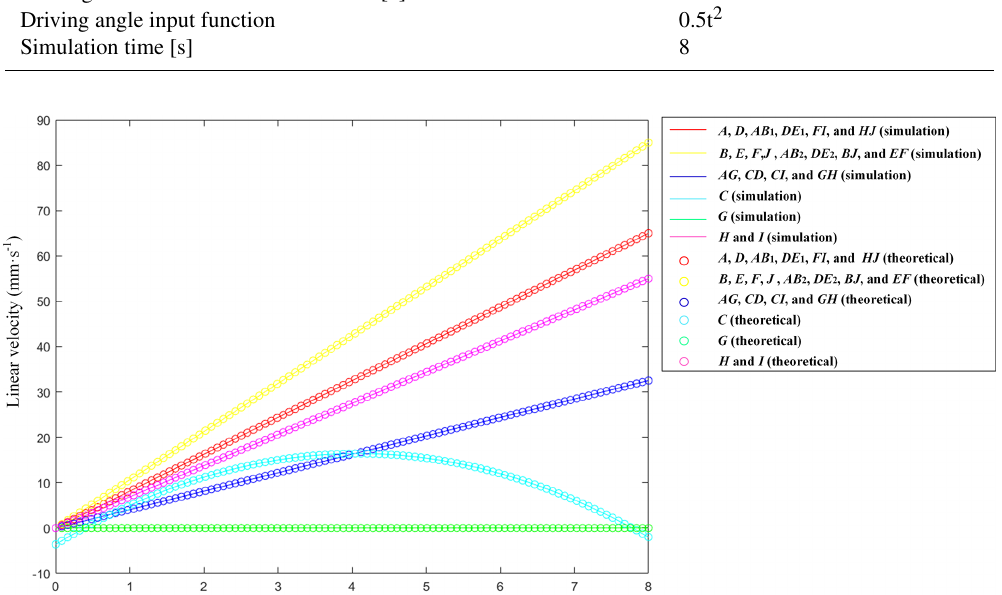
Figure 15. Linear velocity of each component mass center.